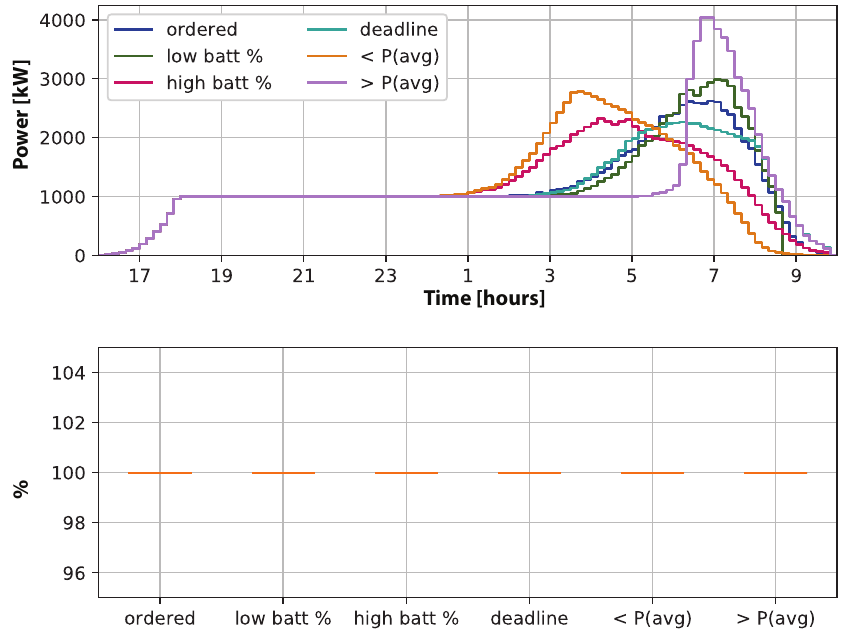
Figure 7. Power profile from 4 p.m. to 10 a.m. in the following day ( top ) and the distribution of battery level ( bottom ) for the “soft”